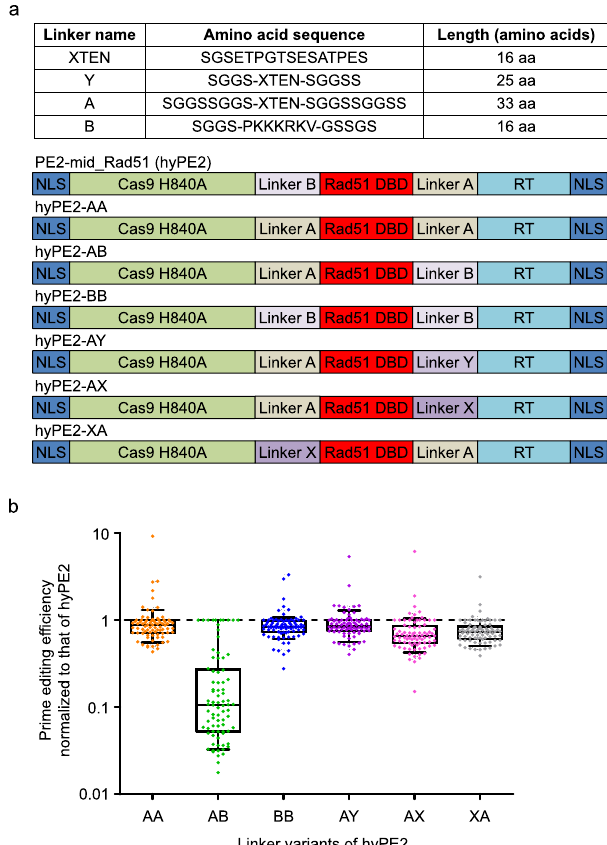
Fig. 2 Evaluation of hyPE2 linker variants. a Detailed information about the linkers that were used and the structures of the hyPE2 linker variants. DBD DNA-binding domain, NLS nuclear-localization signal, RT reverse transcriptase. b Prime-editing ef fi ciencies of hyPE2 variants normalized to the ef fi ciency of hyPE2 at the same target sequences, which had been lentivirally integrated in HEK293T cells. Adjusted fold increases are shown on the y axis. Data of minimum-to-maximum values are presented. For the boxes, the top, middle, and bottom lines represent the 25th, 50th, and 75th percentiles, respectively. The whiskers indicate the 10th- and 90th- percentile values. The number of pegRNAs n = 82. Source data are provided as a Source Data fi